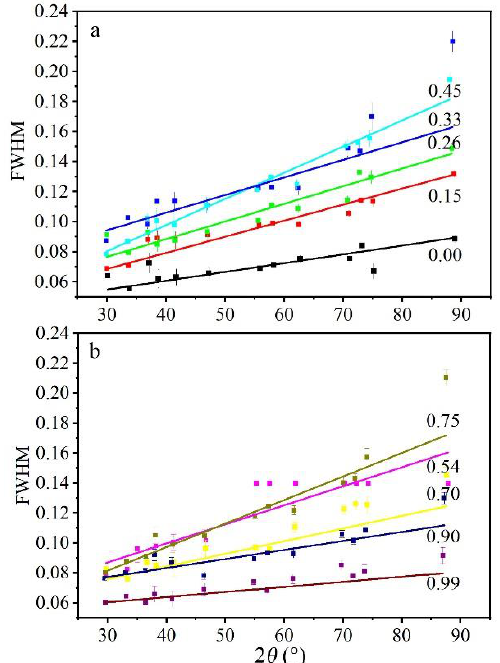
Figure 6. The full width at half maximum (FWHM) values of X-ray di ff raction peaks (used for unit-cell calculation) on garnets with di ff erent compositions. ( a ) grossular-rich samples, ( b ) andradite-rich samples. The number represents the mole fraction of andradite component. Garnet solid solutions with intermediate composition showed broader XRD peaks than end-members. For samples with a constant composition, XRD peak broadening increased with Bragg angle (lines with di ff erent colors only serve as labels and have no practical meaning).